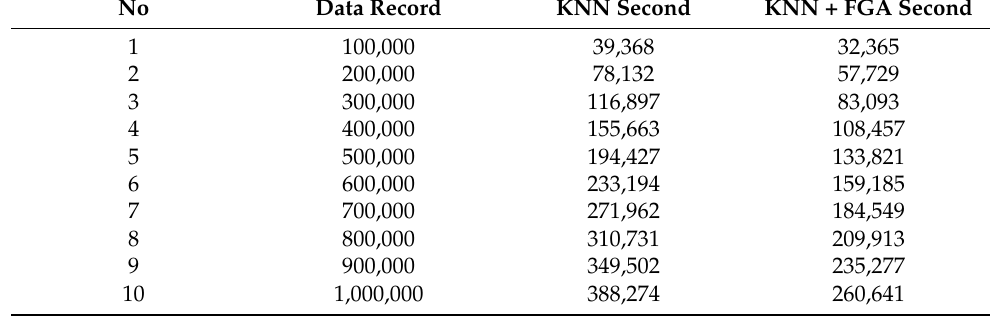
Table 3. Table of computational performance of KNN and KNN using FGA.